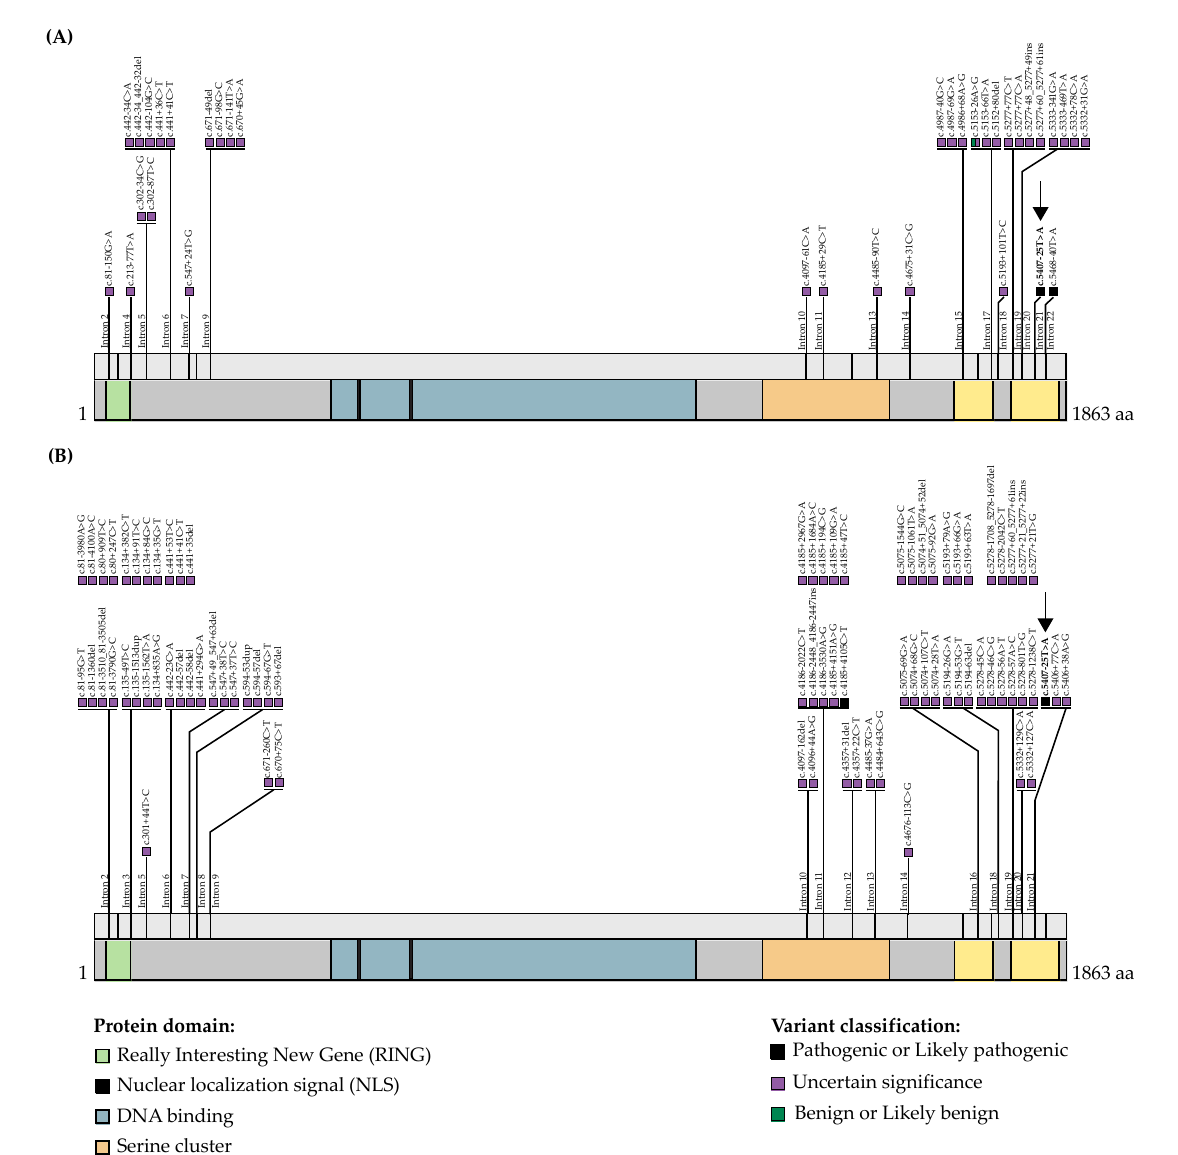
Figure 2. Annotated curated intronic BRCA1 variants. The BRCA1 transcript NM_007294.4 (NCBI Reference Sequence (RefSeq) database (ncbi.nlm.nih.gov/nuccore/NM_007294.4), indicating protein encoded domains was annotated with BRCA1 c.5407-25T>A (indicated with an arrow) and intronic variants classified as pathogenic, likely pathogenic or unknown significance based on ClinVar and/or American College of Medical Genetics and Genomics guidelines were ( A ) submitted to Clin- Var (ncbi.nlm.nih.gov/clinvar/ accessed on 25 January 2022) (see Table S2) or ( B ) reported in the literature (pubmed.ncbi.nlm.nih.gov accessed on 25 January 2022) (see Table S3). Variants were se- lected based on: intronic location beyond ±20 nucleotides from splice sites; rarity (minor allele fre- quency ≤ 0.005); classification as pathogenic, likely pathogenic or variants of unknown significance (VUS) in BRCA1 in the context of hereditary breast and/or ovarian cancer Search terms for PubMed (as in October 2021) articles included: (“brca1 s”[All Fields] OR “genes, brca1”[MeSH Terms] OR (“genes”[All Fields] AND “brca1”[All Fields]) OR “brca1 genes”[All Fields] OR “brca1”[All Fields]) AND (“intron s”[All Fields] OR “intron”[All Fields] OR “intronically”[All Fields] OR “introniza- tion”[All Fields] OR “introns”[MeSH Terms] OR “introns”[All Fields] OR “intron”[All Fields] OR